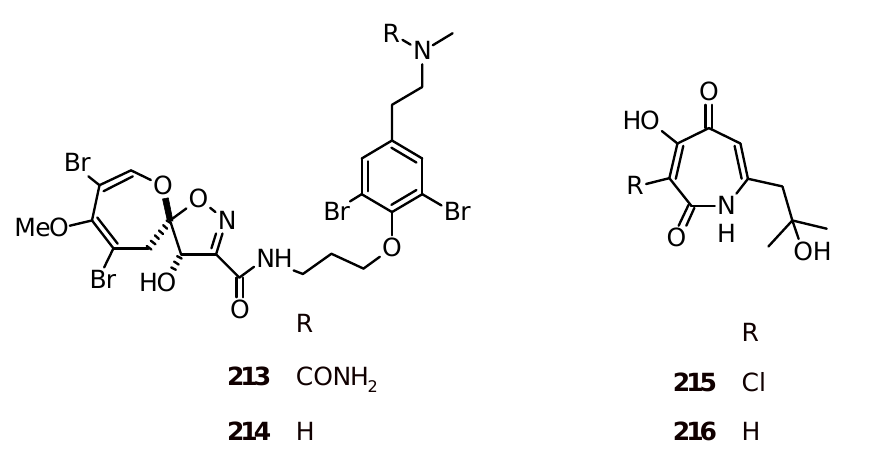
Figure 24. Structures of alkaloids 213 - 216